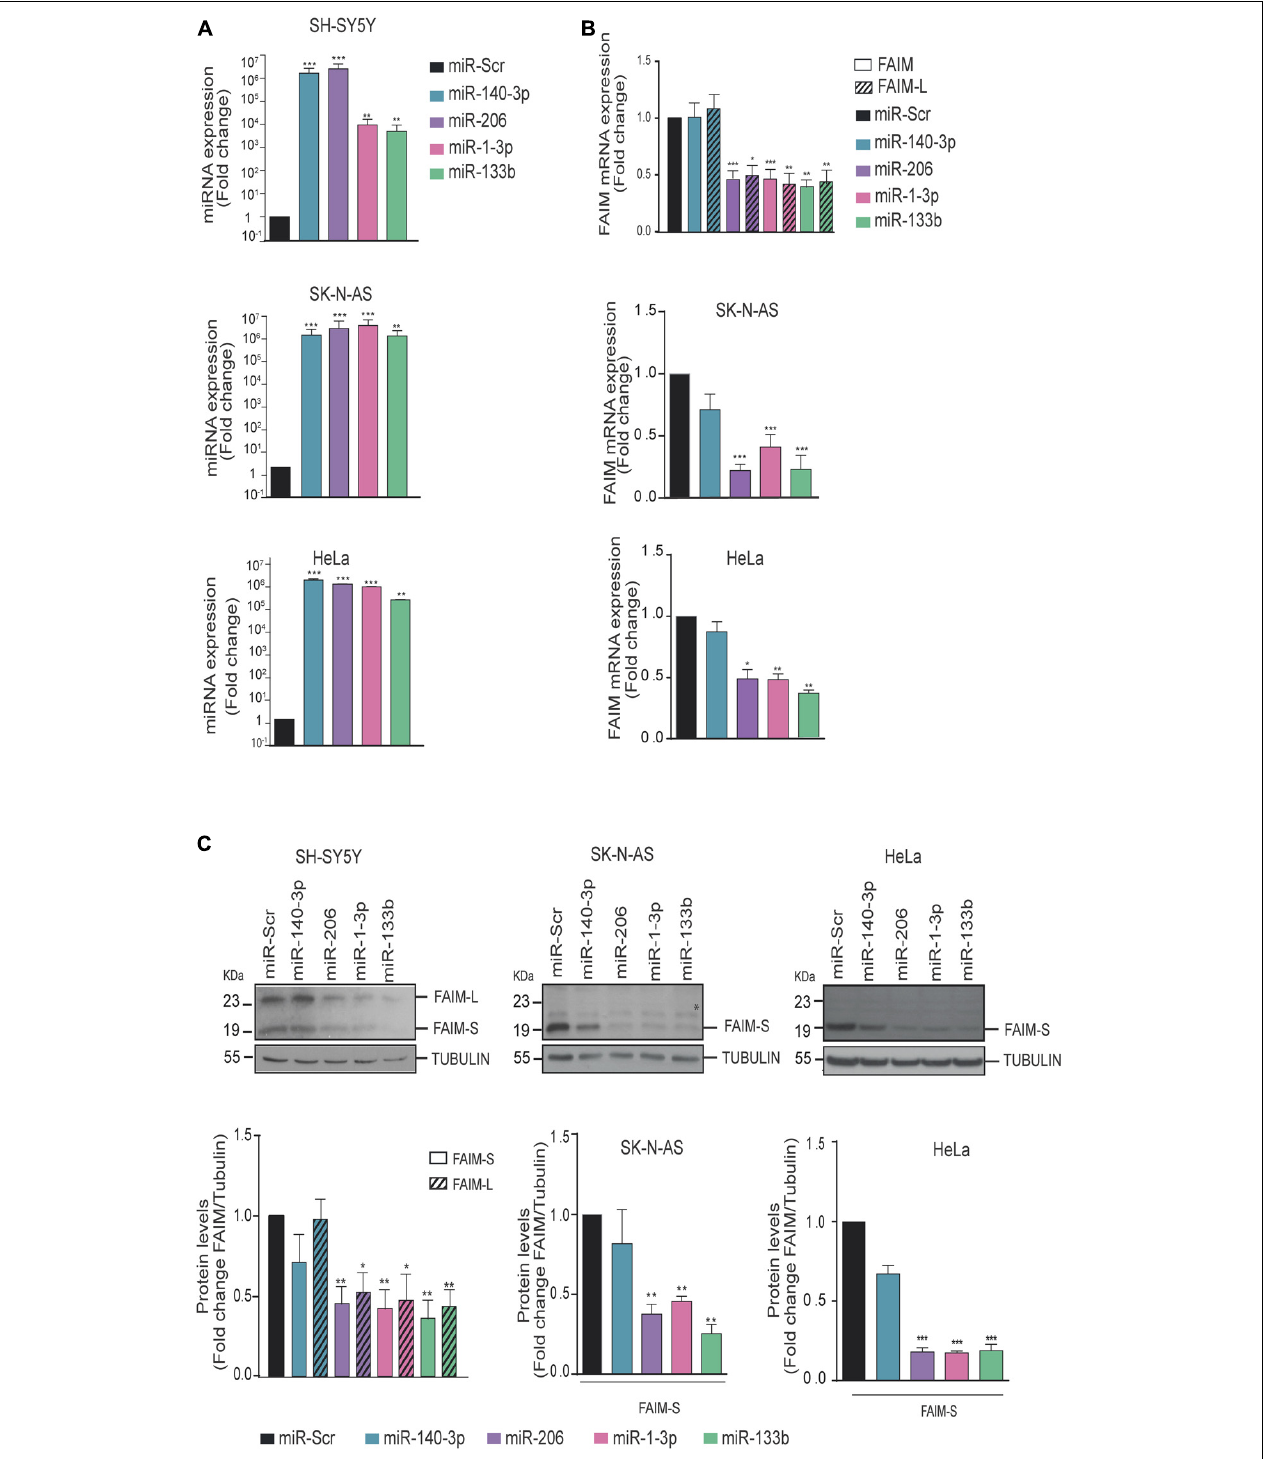
FIGURE 3 | FAIM expression is modulated by miR-206, miR-1-3p, and miR-133b. (A) MiRNAs expression levels were assessed by RT-qPCR. (B) SK-N-AS, SH-SY5Y and HeLa cells were transfected with 25 nM of miR-140-3p, miR-206, miR-1-3p, miR-133b or a control miRNA (miR-Scr) and FAIM mRNA expression levels were assessed by RT-PCR. (C) Representative western blots of FAIM in neuroblastoma and HeLa cells transfected with the indicated miRNAs. Lower panels show the quantification of the band intensity of the western blots normalized to the control miRNA (miR-Scr) condition. *Unspecific band. Graphs represent the mean of four independent experiments ± SEM. Tubulin was used as a loading control. * P < 0.05, ** P < 0.01, *** P < 0.005.